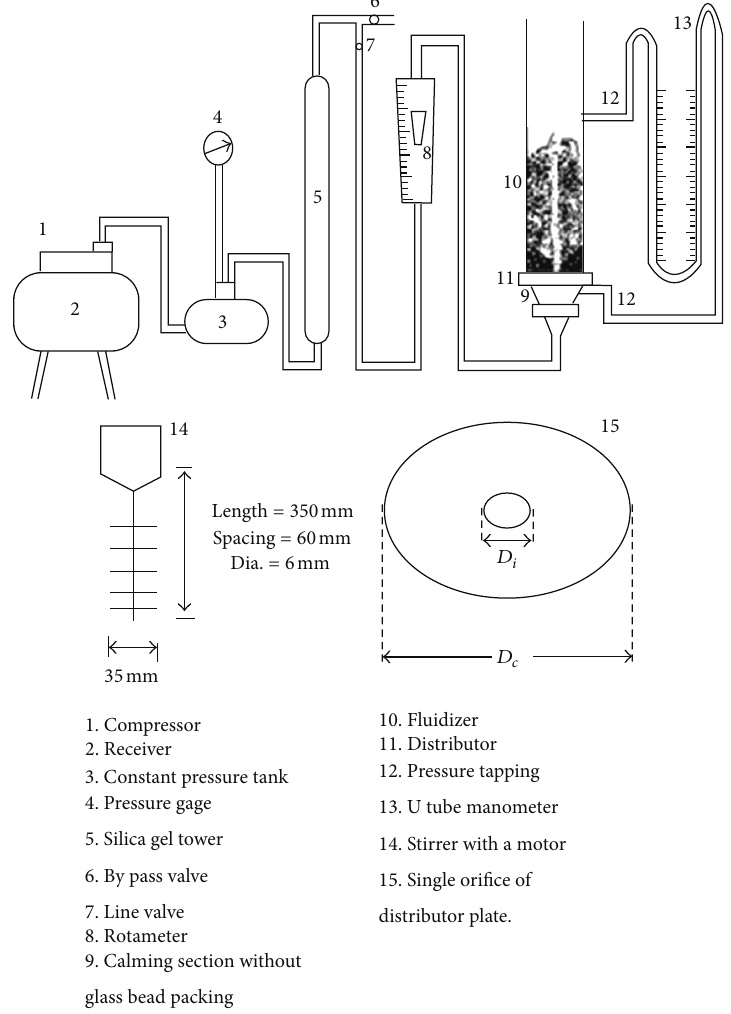
Figure 2: Schematic view of the experimental